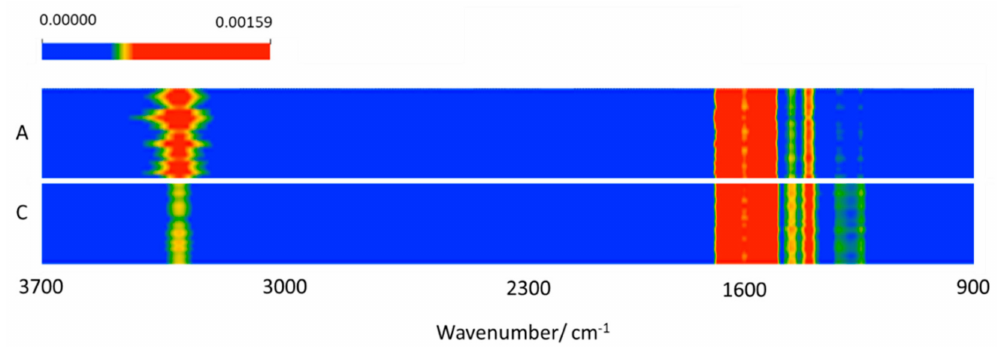
Figure 1. Heat map for the samples belonging to the two groups ( A , ADHD; C , control).